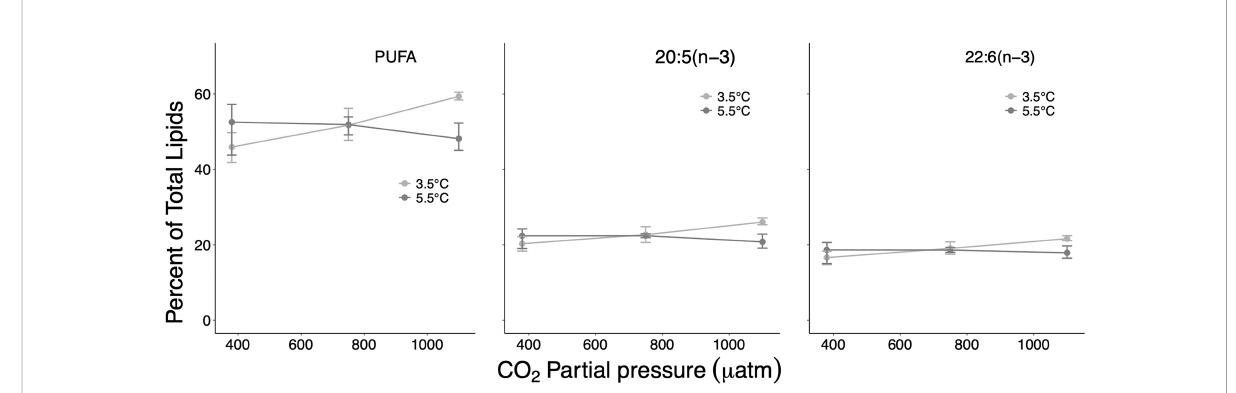
FIGURE 5 Percent contribution of polyunsaturated fatty acids (PUFA) and of the two dominating PUFAs 20:5(n-3) and 22:6(n-3) on total lipids at the different treatment and factor levels. Error bars depict 95% con fi dence